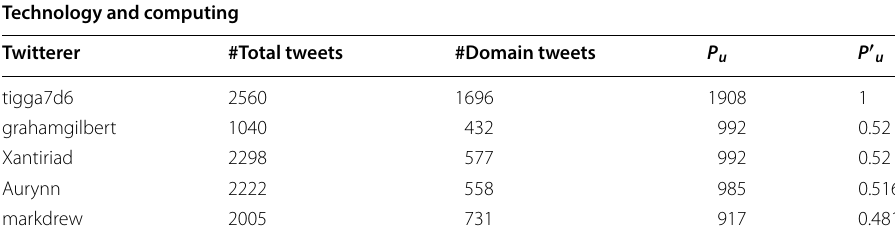
Table 4 Domain-based user’s content replies P u,d Technology and